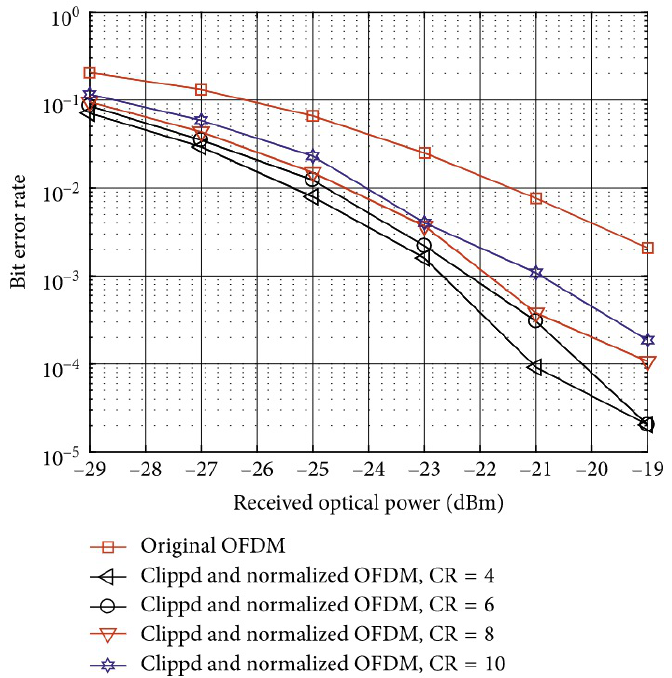
Fig. 4 Comparison of FRFT and FFT reduced PAPR with different twiddle factors under the SLM algorithm. FFT, fast Fourier transform; FRFT, fractional Fourier transform; SLM, selective